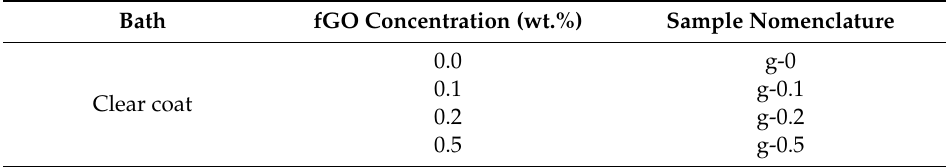
Table 1. Labelling of samples with di ff erent functionalized graphene oxide (fGO) concentration. Bath fGO Concentration